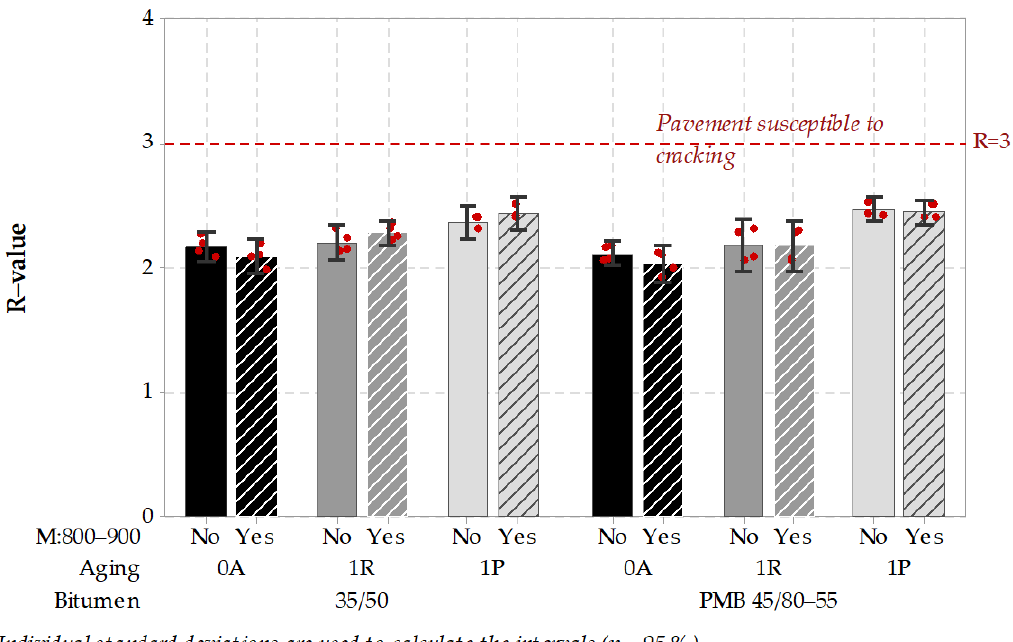
Materials 2021 , 14 , x FOR PEER REVIEW Figure 16. Interval plot of R-value of bitumen obtained in different aging conditions (the higher, the worse).